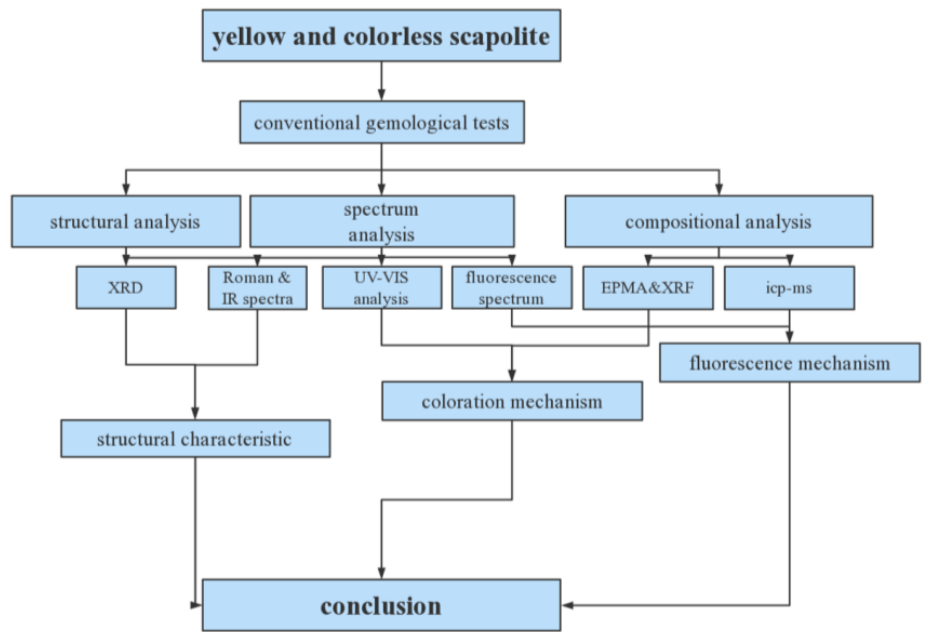
Figure 3. Experiment flow chart.